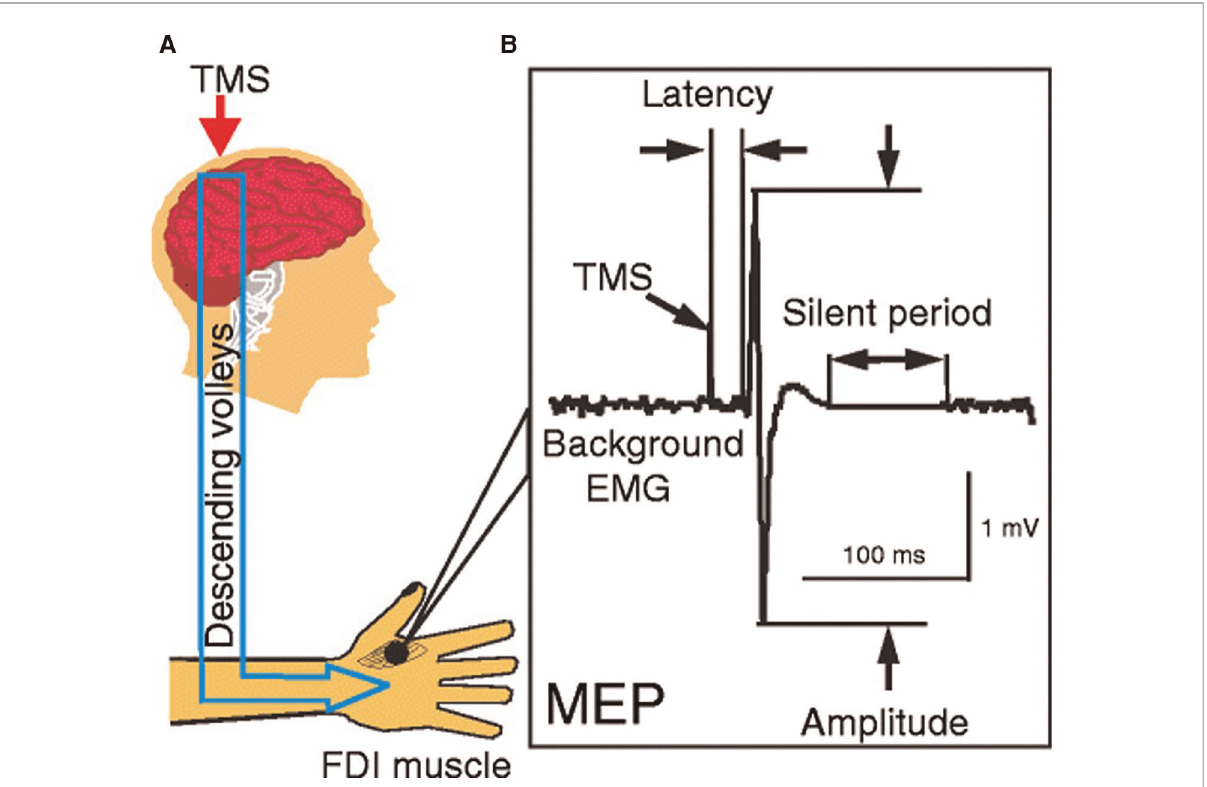
FIGURE 1 Single pulse transcranial magnetic stimulation. ( A ) Stimulation of primary motor cortex to activate corticospinal tracts and collection of responses from the fi rst dorsal interossei (FDI) muscle; ( B ) characteristics of motor evoked potential and silent period — amplitude, latency, and silent period duration [Reprinted from Ni and Chen et al., 2015 (99); reprint permitted under Creative Commons Attribution 4.0 International